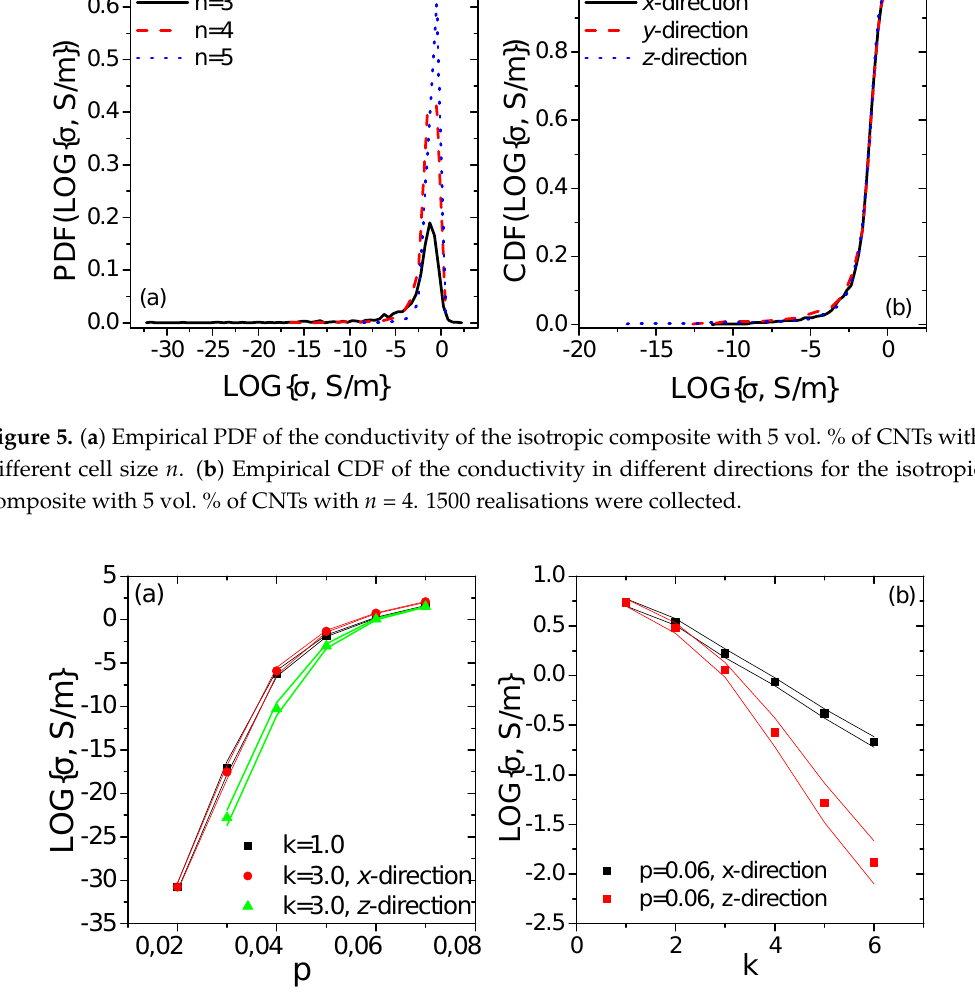
Figure 6. Conductivity dependence ( a ) on the concentration for the initial and deformed composite in different directions, and ( b ) on the deformation for the samples with 6 vol. % of the CNTs. Symbols stands for the mean values, and lines denote the 95 % confidence interval